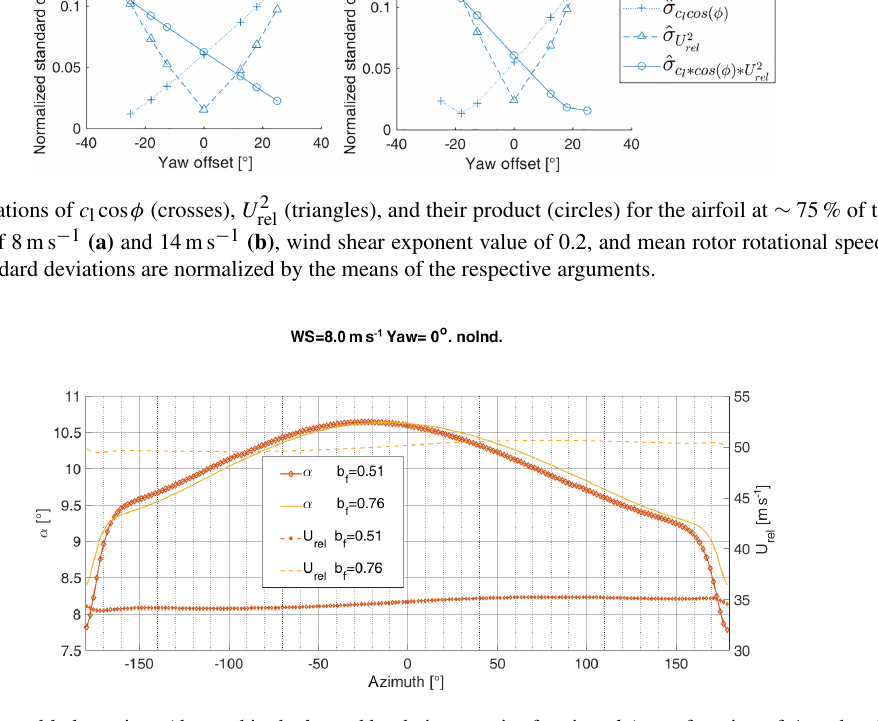
figurations: one including the entire model physics, one with- out UA effects, and one without blade (and tower)